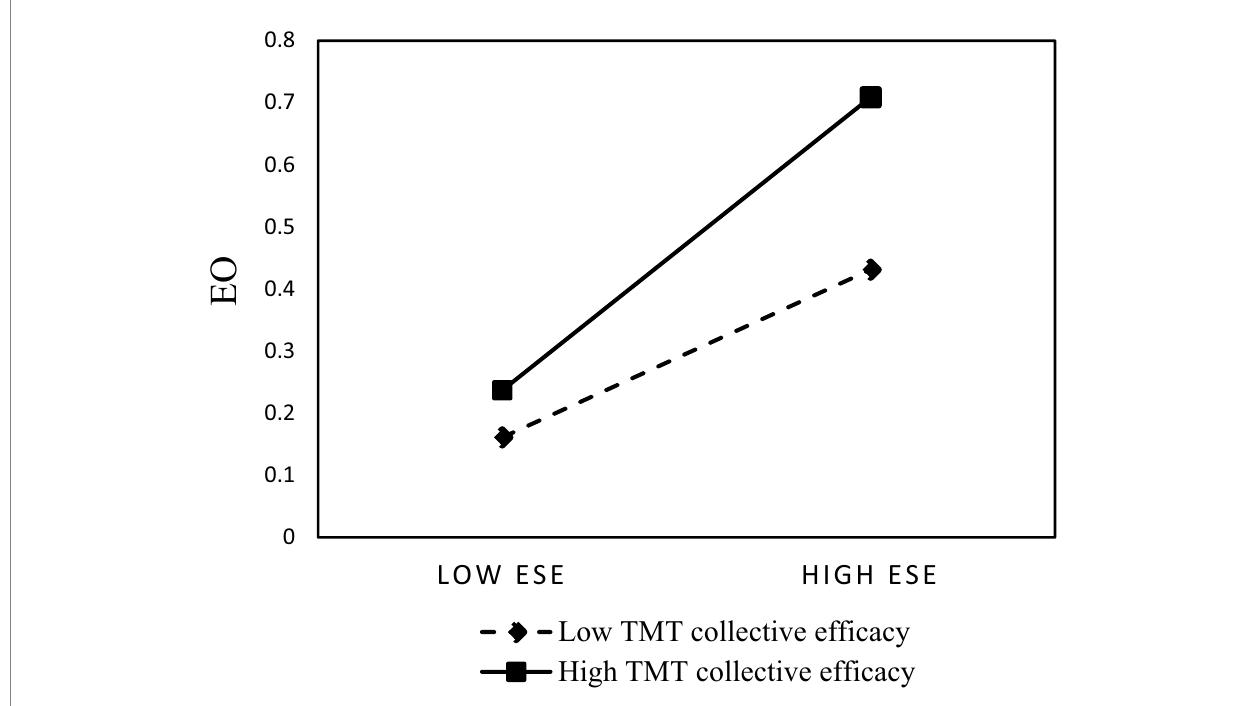
FIGURE 2 Interaction effect of entrepreneurial self-efficacy and TMT collective efficacy on entrepreneurial